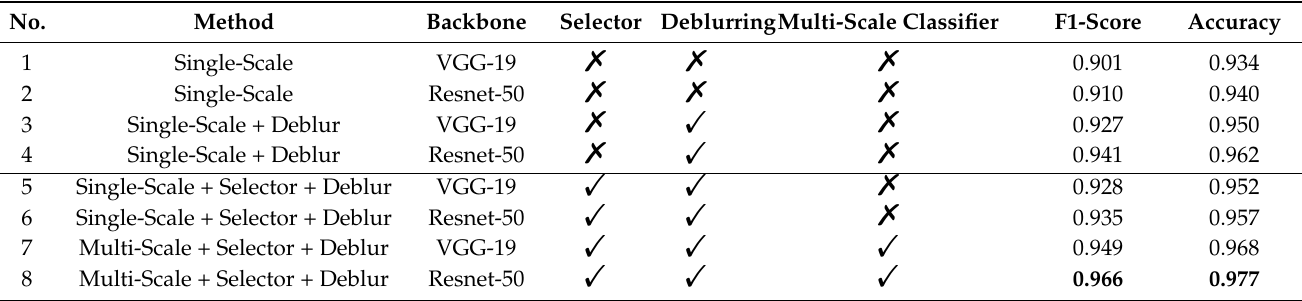
Table 7. The classification results from the four cases: the two groups of ablation experiments for each of the VGG-19 and Resnet-50